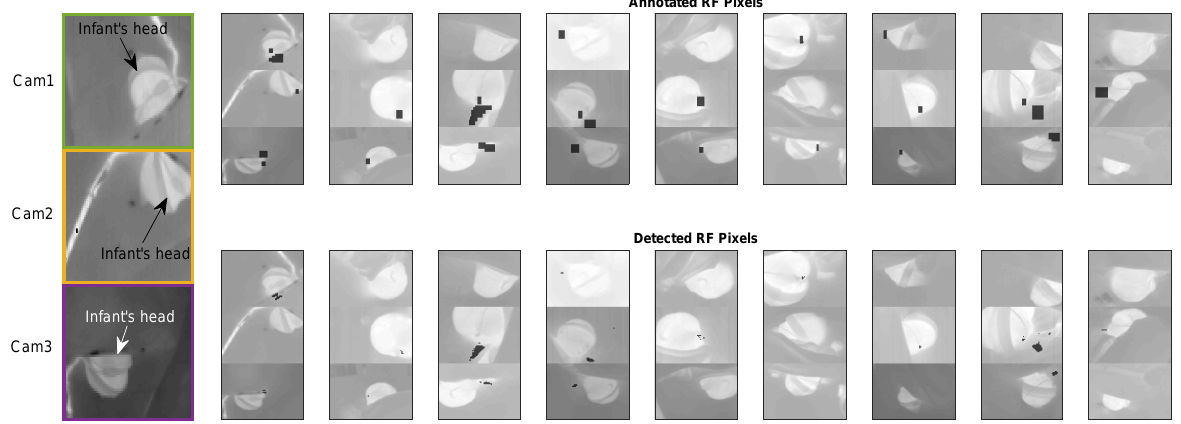
Figure 6. An example thermal image with a description of the content, and examples of the annotated RF pixels and the detected ones for the different infants included.